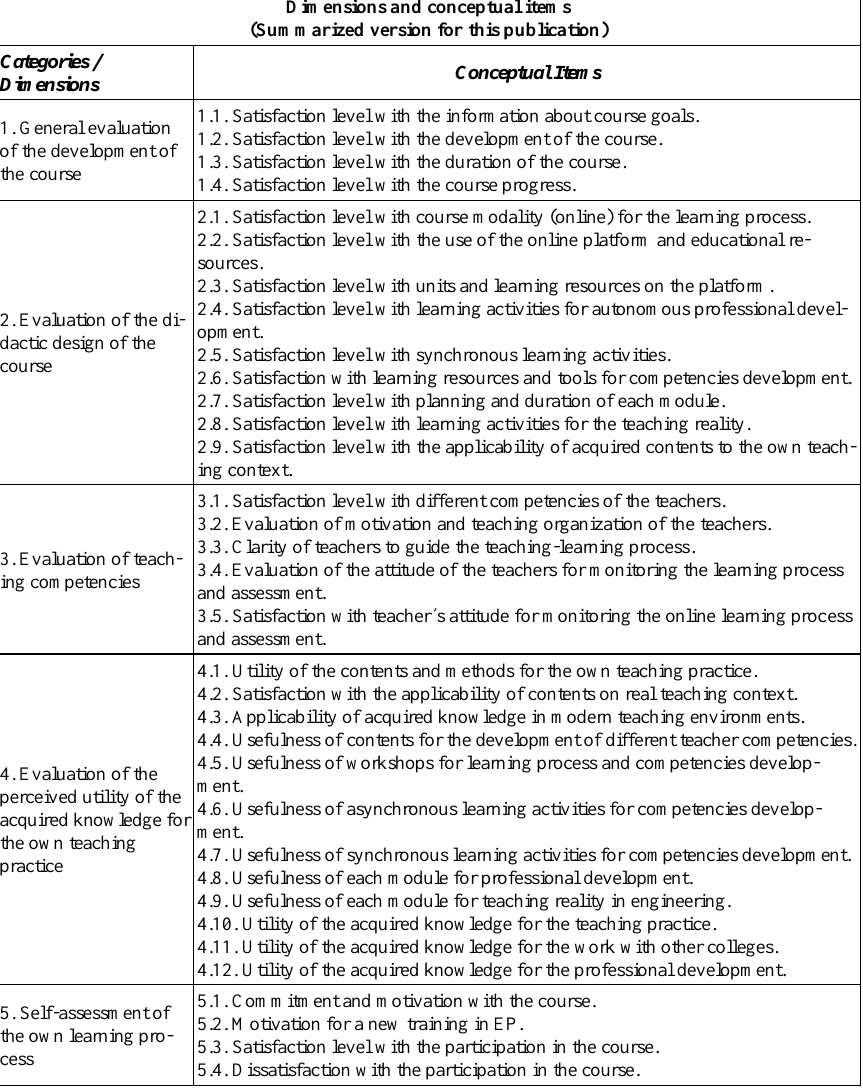
Table 2. Dimensions and conceptual items for the evaluation instrument [5,